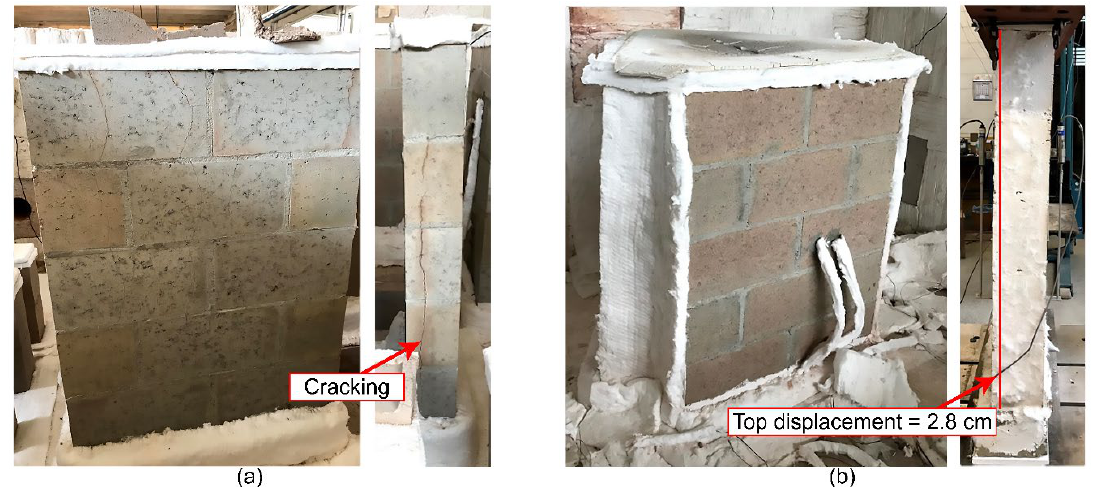
Figure 10. Small walls after the test: fire on (a) all faces and (b) one face (trio).